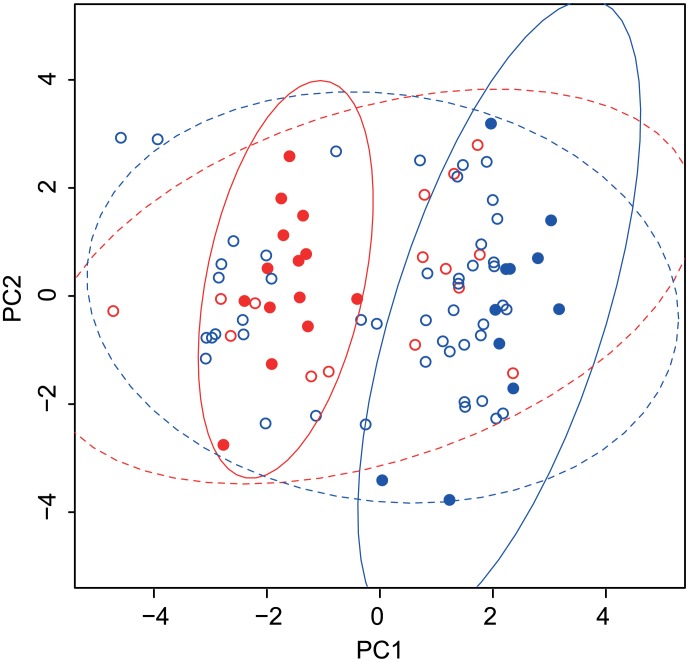
The first two principal components describing colour and size of cuckoo and warbler eggs.Blue symbols - great reed warbler eggs (filled) or cuckoo eggs found in great warbler nests (open); red symbols - reed warbler eggs (filled) or cuckoo eggs from reed warbler nests (open). Lines represent bivariate 95% confidence ellipses. Line colours correspond to circle colours. Solid lines - host species; dashed lines - cuckoos.